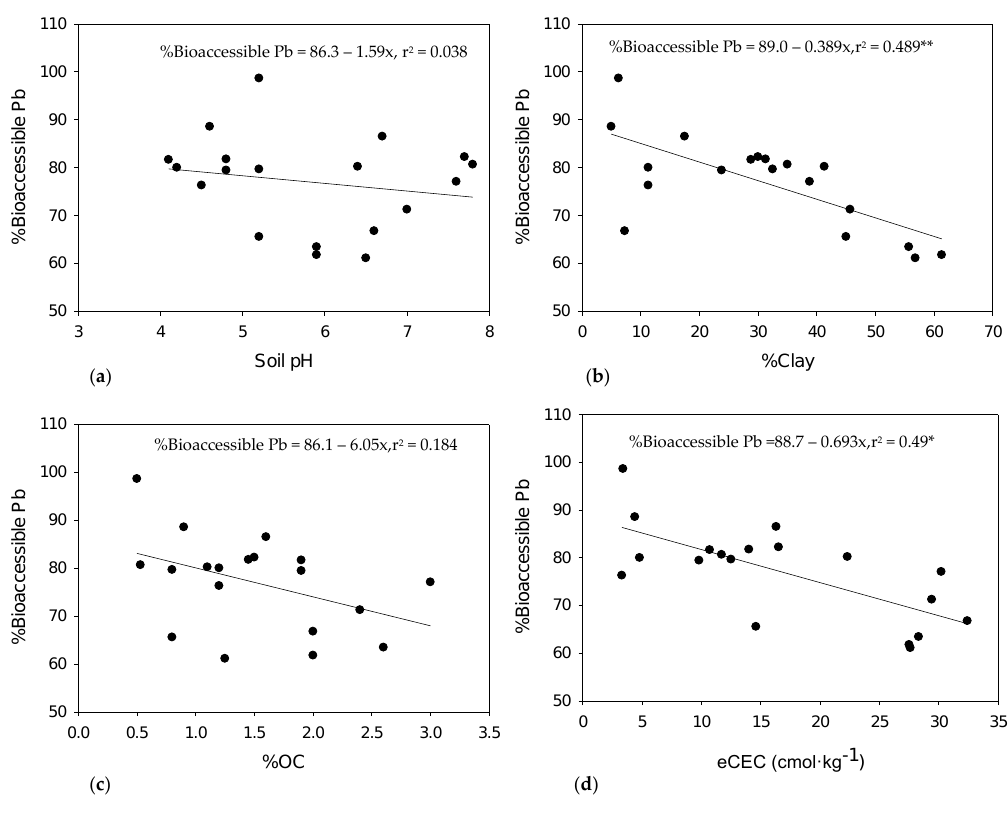
Figure 3. Effect of hydrous oxides on %bio-accessible (IVBA) Pb. ( a ) FeOx (mmol·kg −1 ) effect on %bio-accessible Pb ( b ) AlOx (mmol·kg −1 ) effect on %bio-accessible Pb ( c ) Log FeOx (mmol·kg −1 ) effect on %bio-accessible Pb ( d ) Log (FeOx + AlOx) (log mmol·kg −1 ) effect on %bio-accessible Pb.